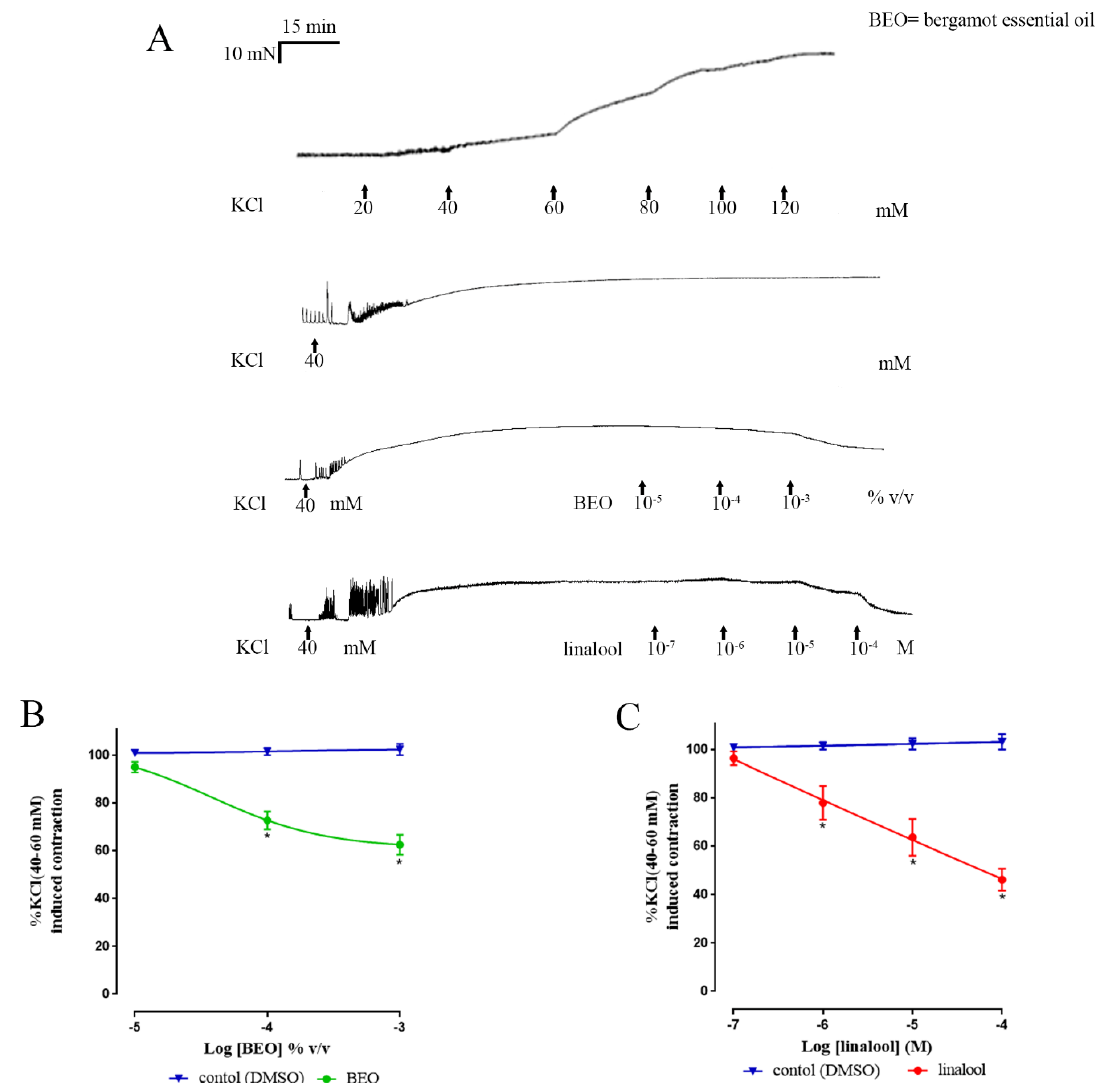
Figure 4. Inhibition by BEO and linalool of the contraction evoked by a submaximally-e ff ective concentration of KCl in human isolated colon. Panel ( A ) shows examples of experimental records illustrating a cumulative concentration-response curve to KCl and the e ff ects of vehicle, BEO and linalool on the sustained contraction evoked by the submaximally-e ff ective concentration of KCl. Panel ( B ) shows the concentration–response curve for BEO and panel ( C ) shows the concentration–response curve for linalool. Note that the values for BEO are given as volume / volume of bathing solution, whereas the concentrations of linalool are given as molar values. Each point represents the mean of patients studied: BEO n = 4 and linalool n = 4. The cumulative concentration-e ff ect was determined by combined data obtained of both regions of colon (ascending + descending) and were fitted by non-linear regression to a three or four-parameter Hill equation. Vertical lines show mean ± sem. * p ≤ 0.05 versus control ( t- tests).